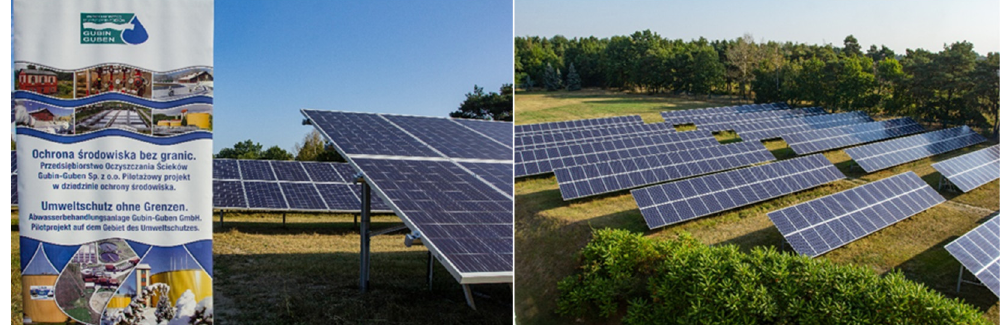
Figure 5. Solar photovoltaic power plant (photo by WWTP ’ s Archive) .